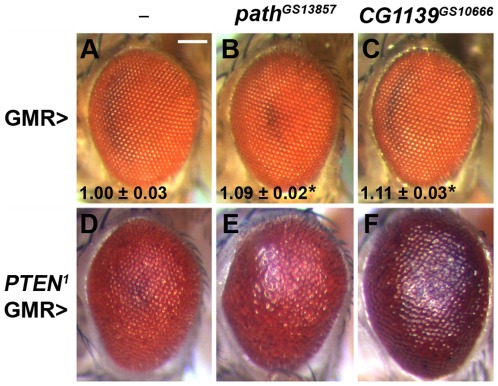
The growth-promoting activity of PAT transporters is synergistically enhanced by hyperactivation of PI3K/Akt signalling.(A–C) GAL4-UAS-induced overexpression of the fly PAT transporter genes, path (B) and CG1139 (C) in the differentiating eye with GMR-GAL4 promotes increased growth compared to normal animals (A). (D–F) When overexpressed in a PTEN mutant background (D), the effect of path (E) and CG1139 (F) on growth is synergistically enhanced, resulting in a highly overgrown, bulging eye phenotype. Ommatidial size measurements are given for eyes where the ommatidial array is regularly arranged (n = 6; bottom of panels A–C, mean ± s.d. relative to control (A); *P<0.001, increased relative to control). Fly genotypes are w; GMR-GAL4 (A), w; GMR-GAL4/pathGS13857 (B), w; GMR-GAL4/CG1139GS10666 (C), y w; PTEN1 FRT40A/P[w+]l(2)3.1 FRT 40A; GMR-GAL4 (D), y w; PTEN1 FRT40A/P[w+]l(2)3.1 FRT 40A; GMR-GAL4/pathGS13857 (E) and y w; PTEN1 FRT40A/P[w+]l(2)3.1 FRT 40A; GMR-GAL4/CG1139GS10666 (F).